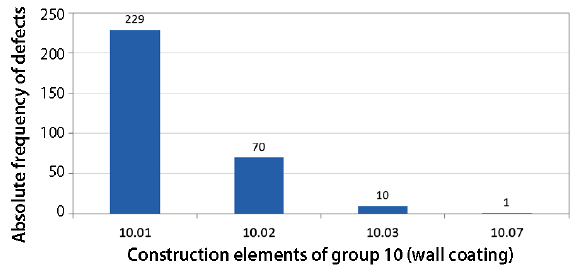
Fig. 22. Absolute frequency of defects according to the specific construction elements belonging to group 10 – wall coatings